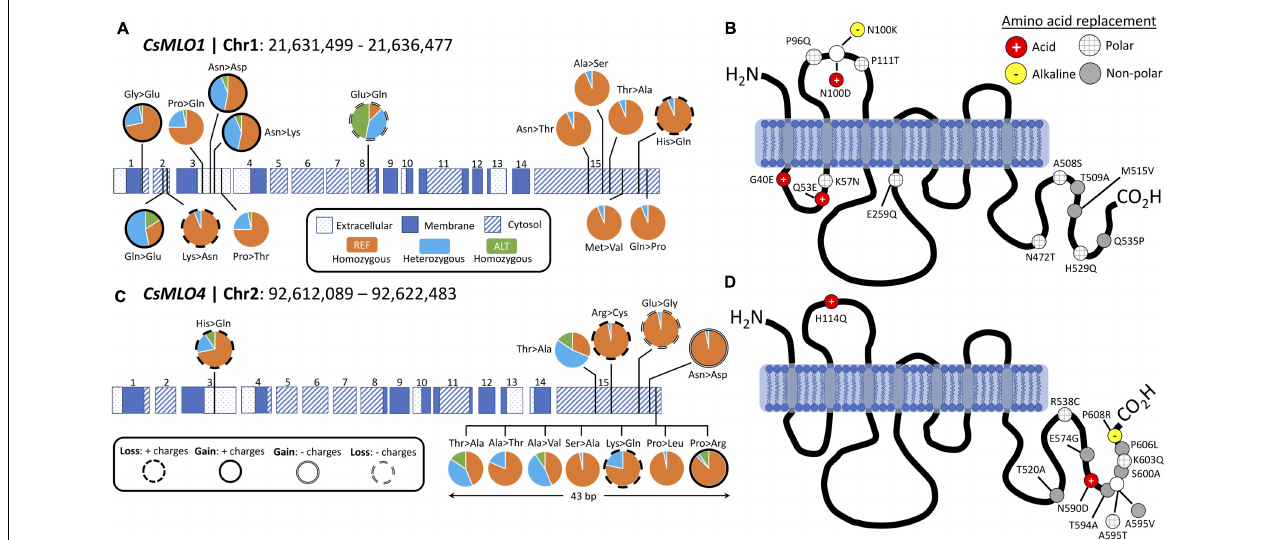
FIGURE 6 | Protein structure and polymorphism analysis of the two clade V genes ( CsMLO1 and CsMLO4 ) in 32 distinct cannabis cultivars aligned against the CBDRx reference genome. Panels A and B exhibit all non-synonymous nucleic acid substitutions (A) and amino acid replacements (B) identified in CsMLO1 (located on chromosome 1) from 32 hemp and drug-type cannabis cultivars. Panels (C,D) exhibit all non-synonymous nucleic acid substitutions (C) and amino acid replacements (D) identified in CsMLO4 (located on chromosome 2) from the same 32 hemp and drug-type cannabis cultivars as shown on panels (A,B) . On panels (A,C) (gDNA), pie charts display, for each SNP along the coding sequence, the genotype frequencies calculated among the 32 cultivars. Colored horizontal rectangles on panels (A,C) represent the exons, numbered from 1 to 15: dotted rectangles represent extracellular domains of the resulting protein, while blue and striped rectangles represent membrane and cytoplasmic domains, respectively. Genotype frequency color code on panels (A,C) : samples called as homozygous for the reference allele are depicted in orange, samples called as heterozygous are depicted in light blue, and samples called as homozygous for the alternate allele are depicted in green. On panels (B,D) (amino acid sequence), the gray vertical rectangles depict transmembrane domains and the solid black curves depict cytoplasmic and extracellular loops. Resulting amino acid replacements on panels (B,D) are color-coded according to the gain or loss of polarity: red circles with white cross display a replacement with an acidic amino acid, yellow circles with black hyphen represent a replacement with an alkaline amino acid, gray circles display a replacement with a non-polar amino acid, and gray-striped white circles represent a replacement with a polar